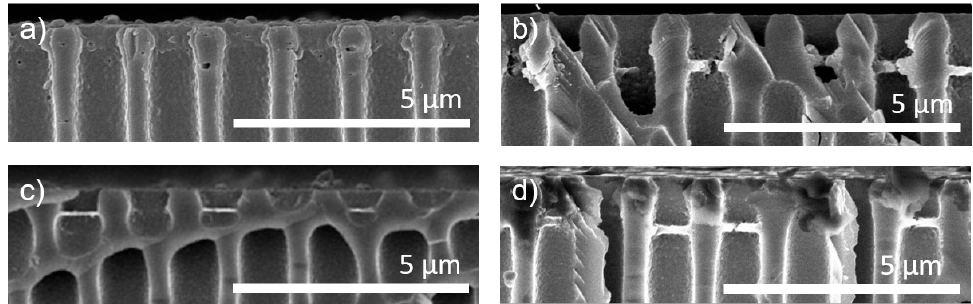
Figure 4. FESEM imaging of porous silicon support cross-sections with three bilayers PDAD- MAC/PSS with ( a ) fully water-wetted support; ( b ) fully air-filled support; ( c ) air-filled support during the first two coating steps and subsequently no wetting control, and ( d ) PEG400-wetted support during polyelectrolyte complexation.